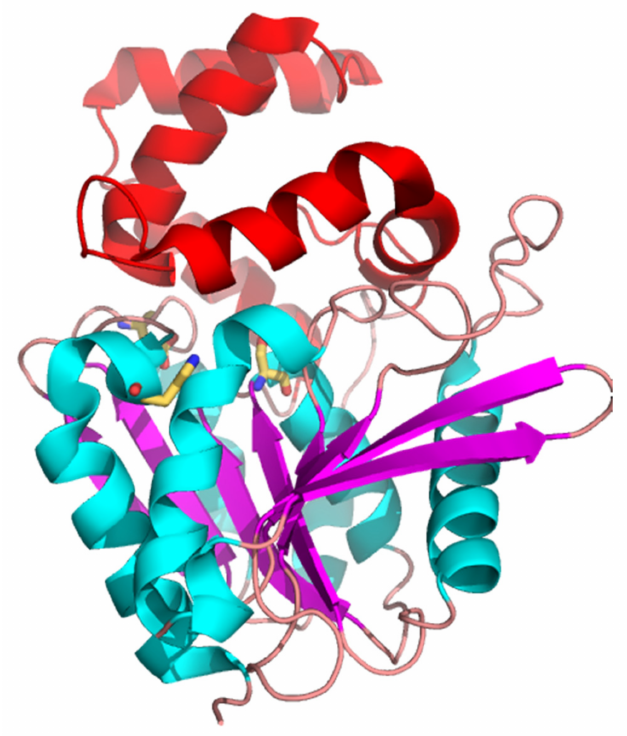
Figure 3. Overall fold of PsyPAH. The catalytic domain is shown in cyan/purple, whereas the cap domain appears in red. The catalytic triad (Ser113, Asp253, His280) is shown in stick mode to account for its position in the catalytic